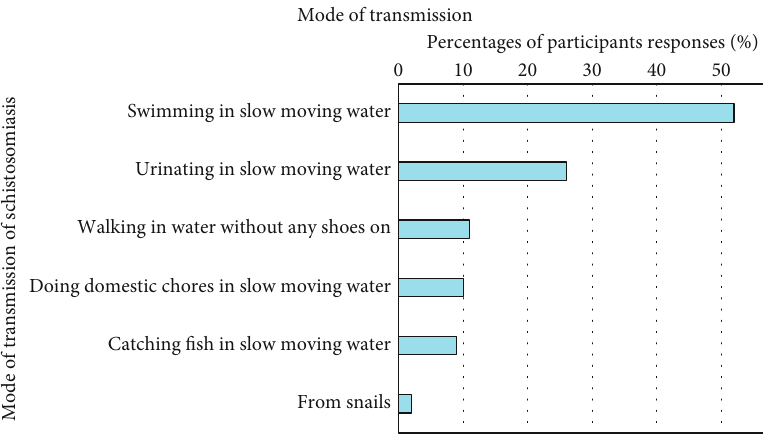
Figure 5: Knowledge about the mode of transmission of schistosomiasis among study